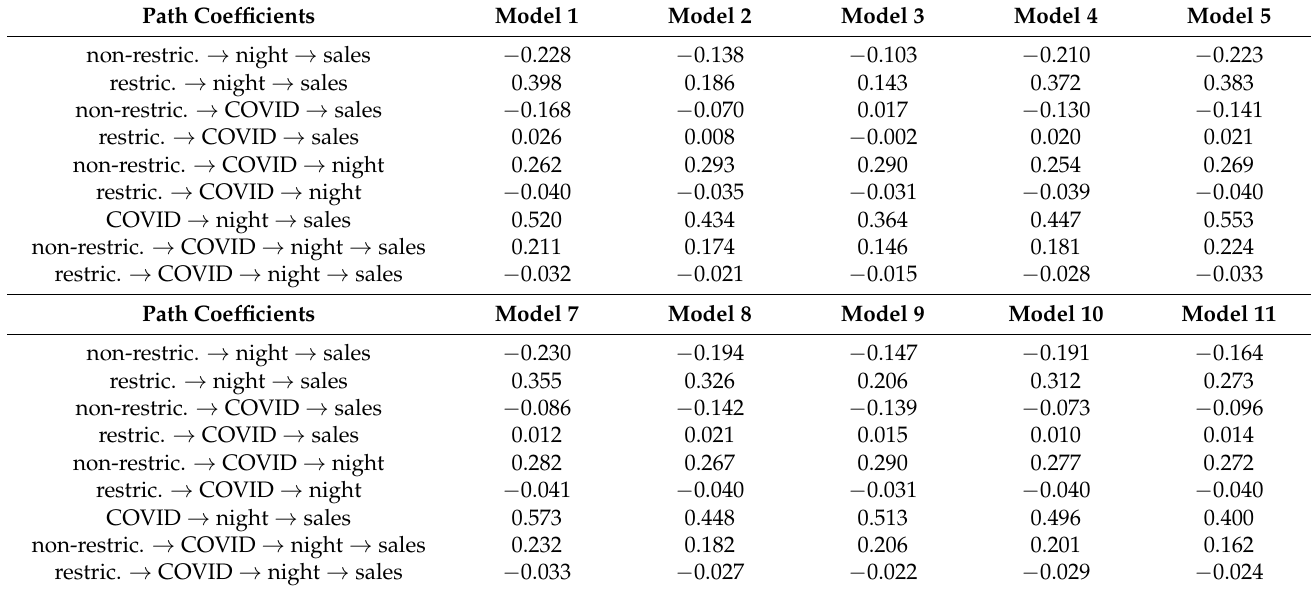
Table A2. Detailed path analysis